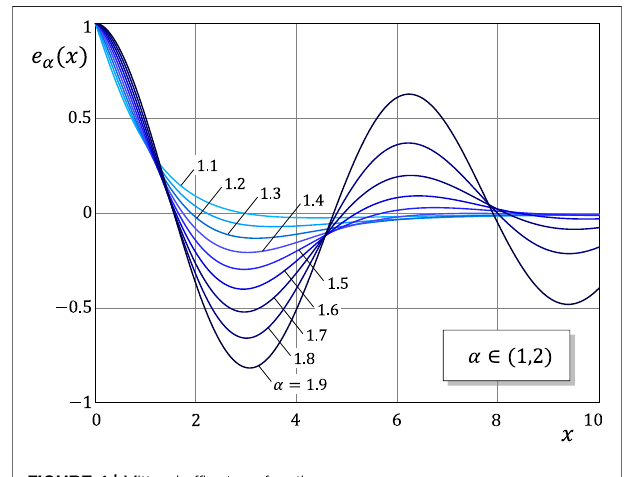
FIGURE 4 | Mittag-Lef fl er type